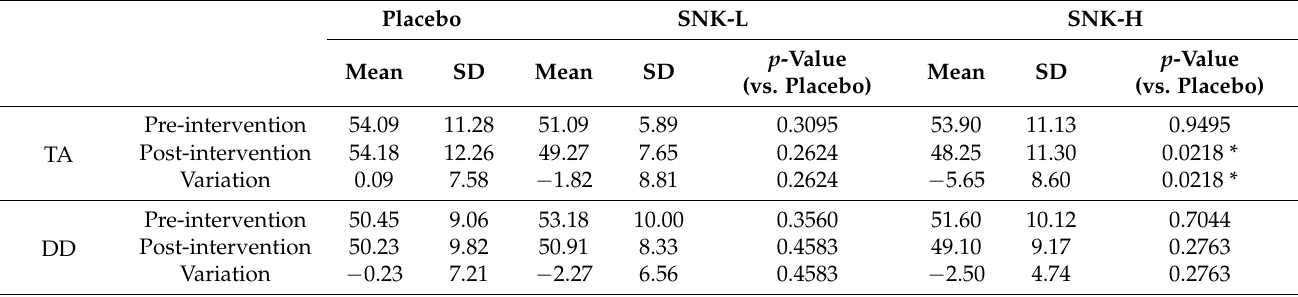
Table 5. Profile of mood states after stress